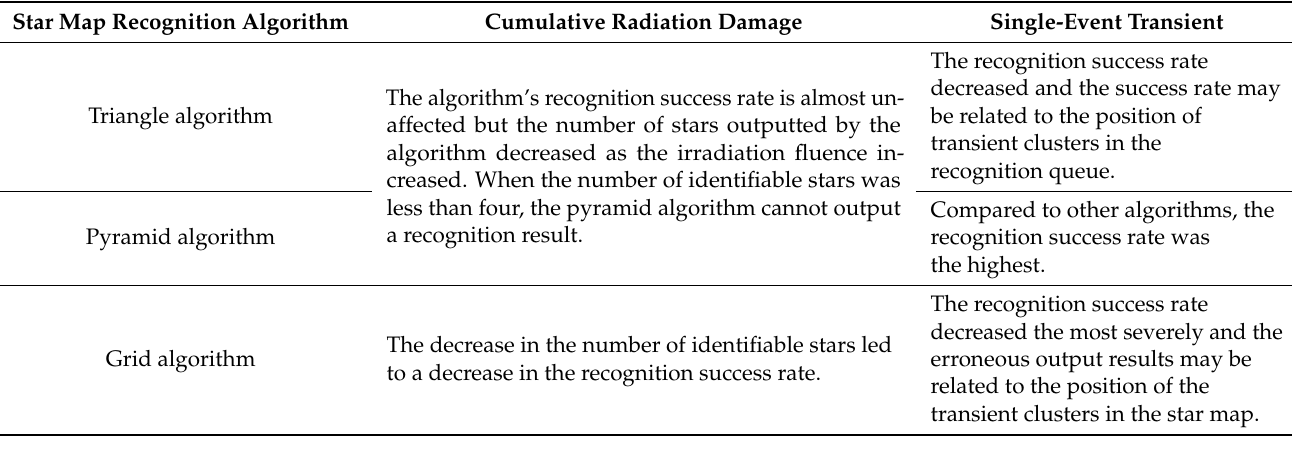
Table 1. The effect of proton irradiation on the success rate of different star map recognition